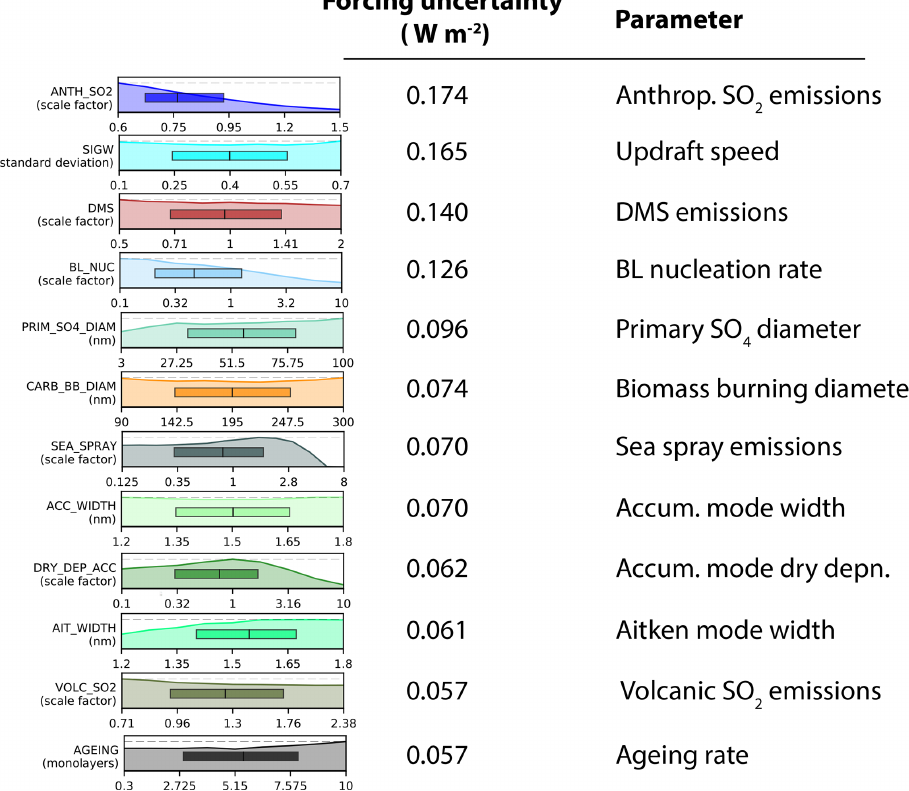
Figure 9. Ranked list of parameters that dominate the uncertainty in global mean aerosol radiative forcing in the ensemble (Yoshioka et al., 2019).